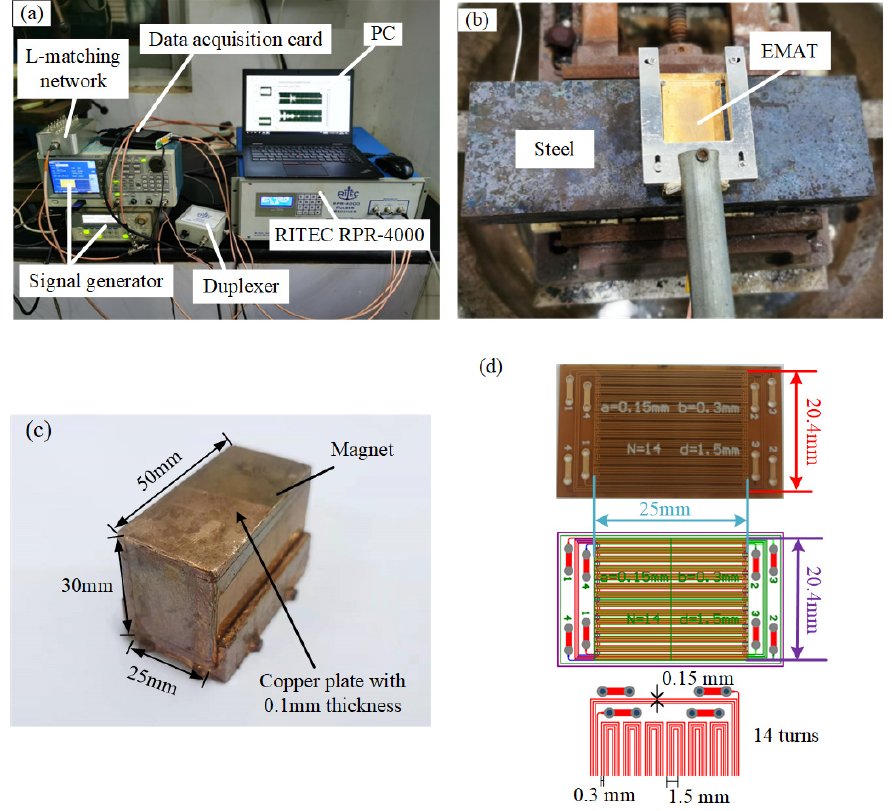
Figure 14. ( a ) EMAT experimental system with high-temperature steel, ( b ) Angled SV wave EMAT, ( c ) Magnet, ( d ) MLC.